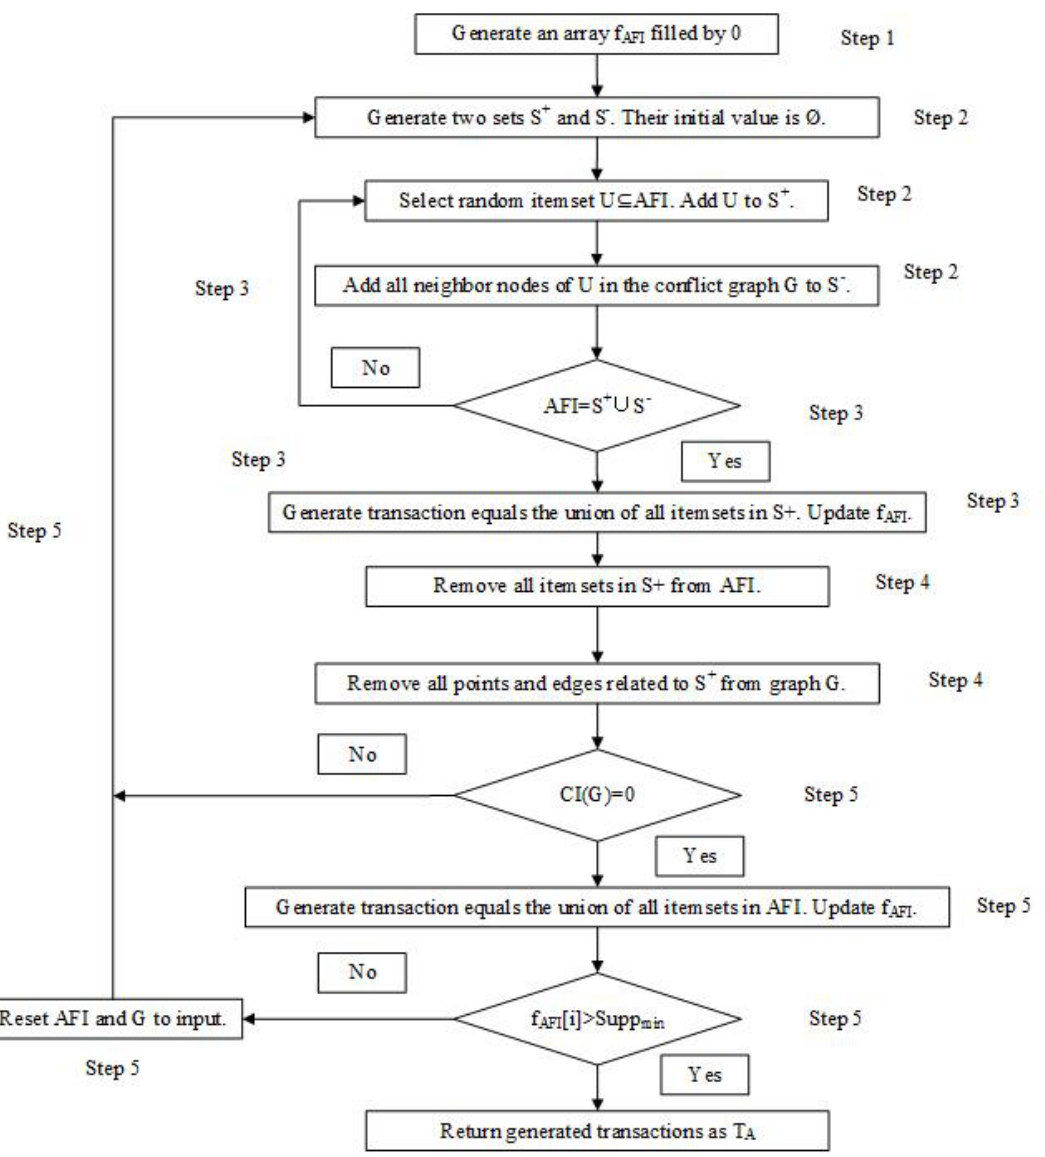
Figure 3. Artificial Transaction